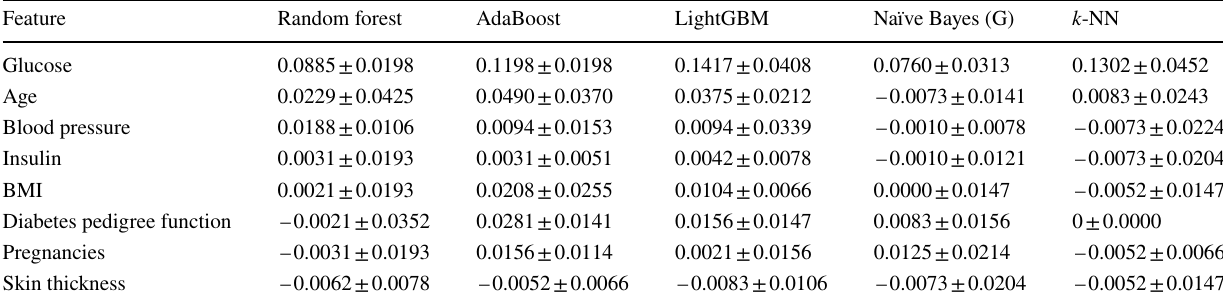
Table 8 Permutation importance score of features of PIMA dataset using ELI5